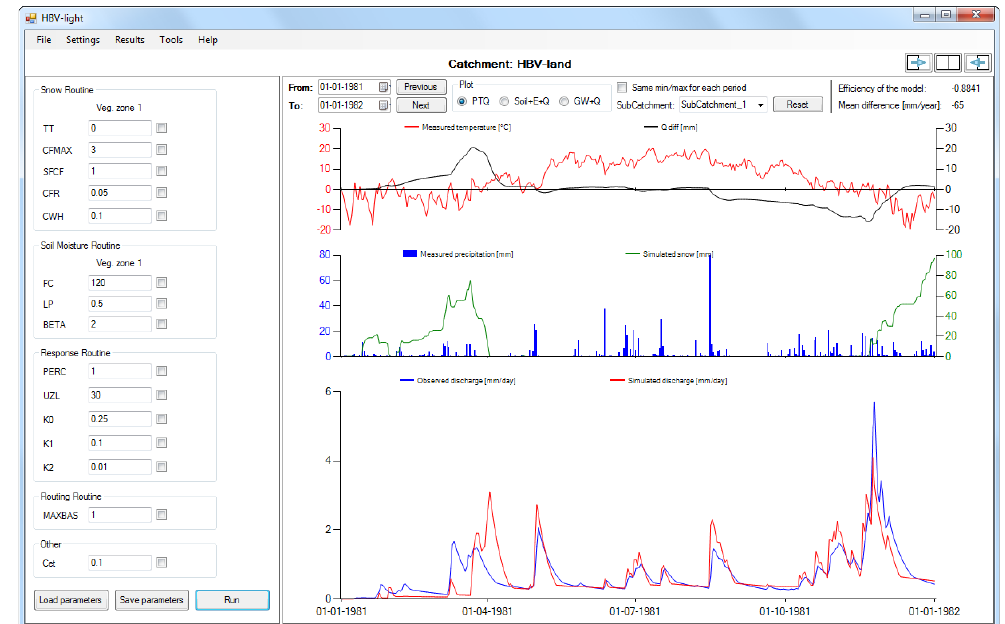
Fig. 2. Screenshot of the main window in